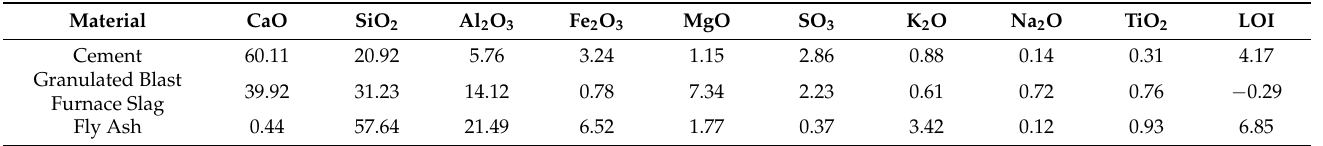
Table 2. Chemical compositions of the materials